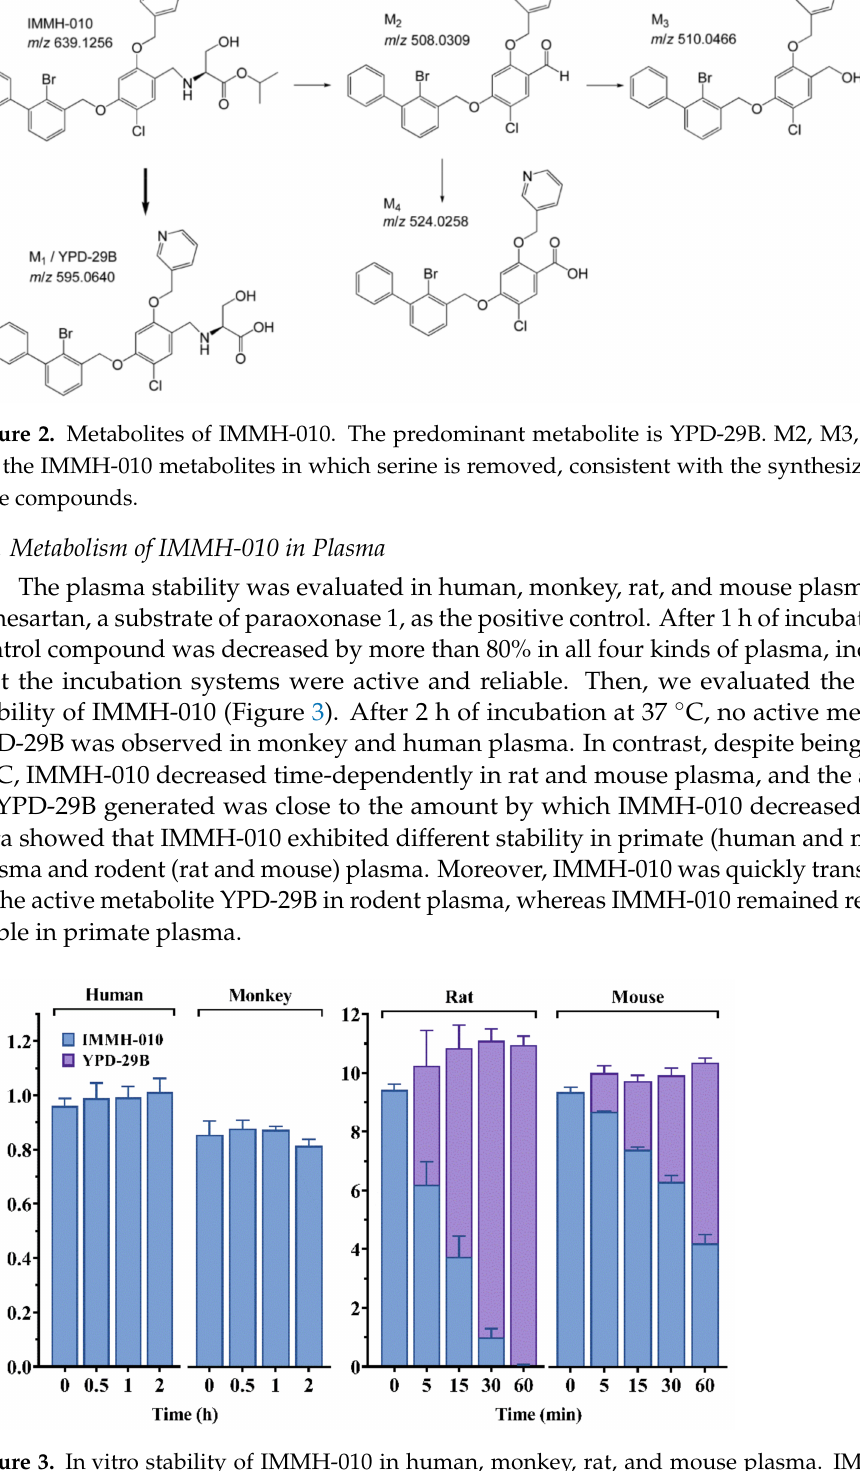
Figure 3. In vitro stability of IMMH-010 in human, monkey, rat, and mouse plasma. IMMH-010 decreased time-dependently in rat and mouse plasma, and the amount of YPD-29B generated was close to the amount by which IMMH-010 decreased. Data are expressed as mean ±